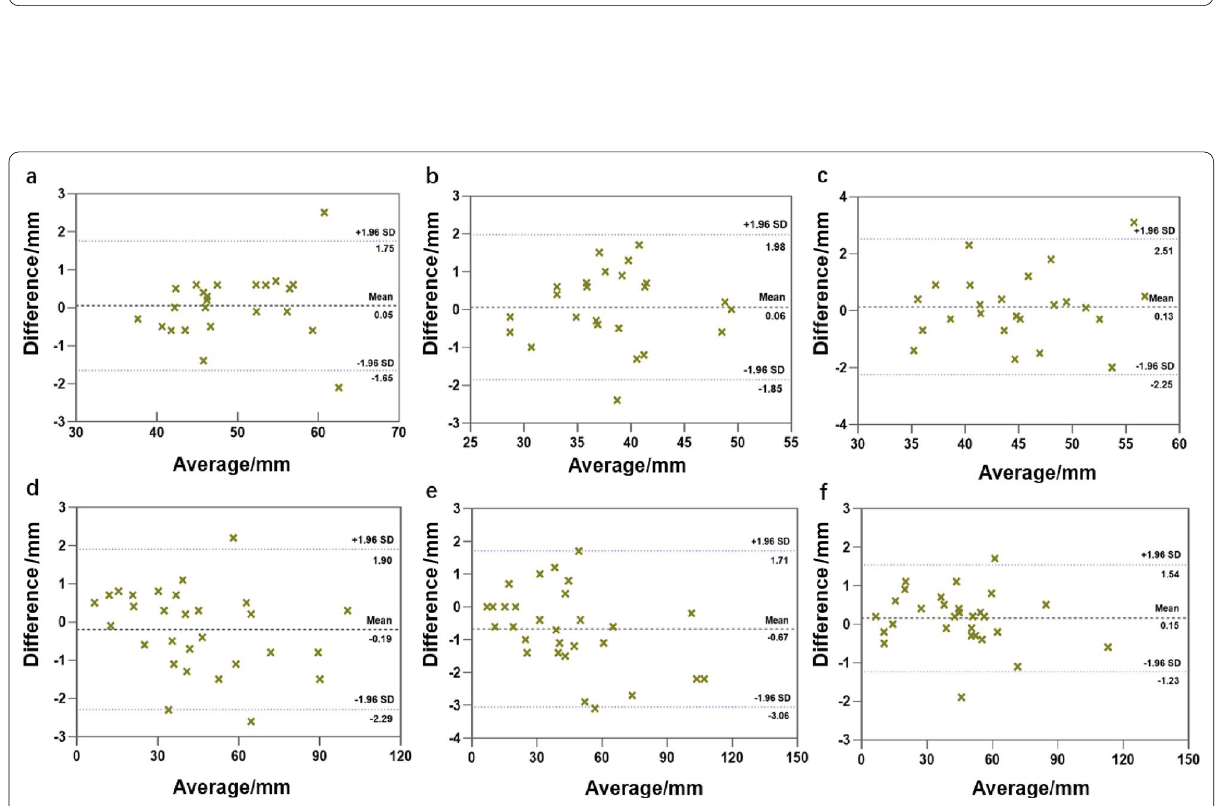
Fig. 3 Bland–Altman plots showing differences versus averages in maximum diameters of the uterus and lesions in T2 DL and T2 S images of the female pelvis. a – c Measurements of the long ( a ), short ( b ), and transverse ( c ) diameters of the uterus. d – f Measurements of the anteroposterior ( d ), vertical ( e ), and transverse ( f ) diameters of leiomyoma lesions. Of the 24 uterine samples, only 2 (8.3%) long diameters, 1 (4.2%) short diameter, and 1 (4.2%) transverse diameter exceeded the 95% limits of agreement. Of the 29 leiomyoma lesion samples, 3 (10.3%) anteroposterior diameters, 2 (6.9%) vertical diameters, and 2 (6.9%) transverse diameters exceeded the 95% limits of agreement, indicating minor geometric distortion of T2 DL images. T2 DL deep learning - accelerated T2‑weighted turbo spin echo sequence; T2 S standard T2‑weighted turbo spin echo